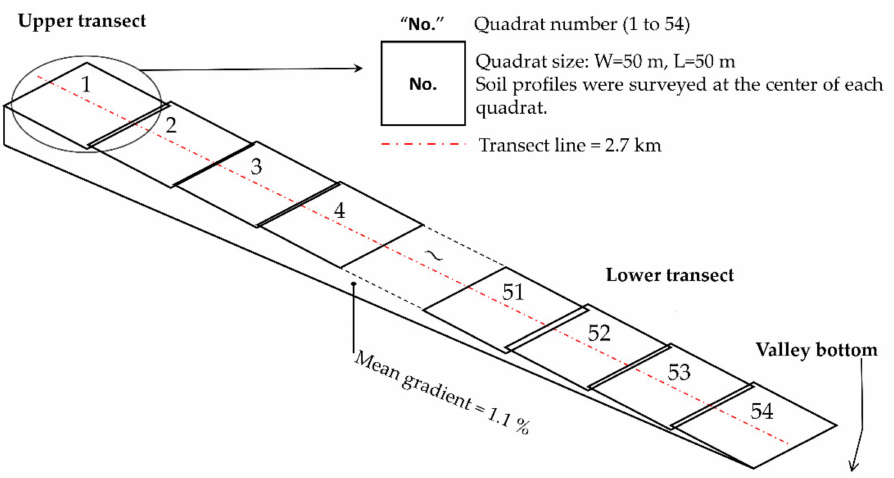
Figure 3. Schematic illustration of the line